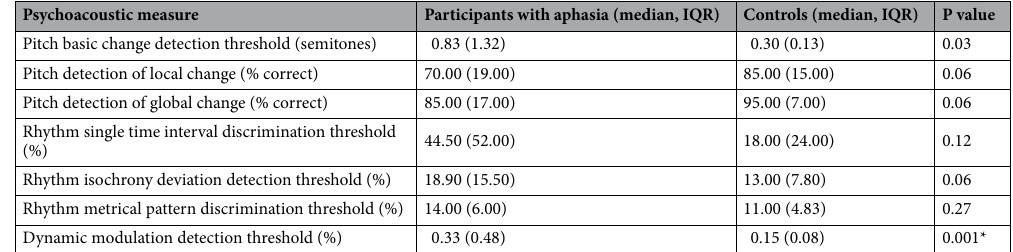
Table 1. Group level comparisons of psychoacoustic scores between participants with post-stroke aphasia and controls. One-way rank ANCOVAs comparing psychoacoustic scores between the post-stroke aphasia subgroup and control group, with years of education included as a covariate. For tests in which the outcome measure was a threshold, lower scores correspond to better performance. * indicates the p-value is significant at the Bonferroni corrected significance threshold of p < 0.007 (corrected for 7